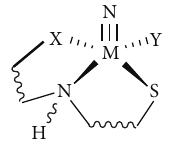
Figure 11: Schematic drawing of the molecular structure of “ 3 + 1 ” nitrido complexes (X = S, N; Y = monodentate ligand; M = 99 m Tc, 188 Re)